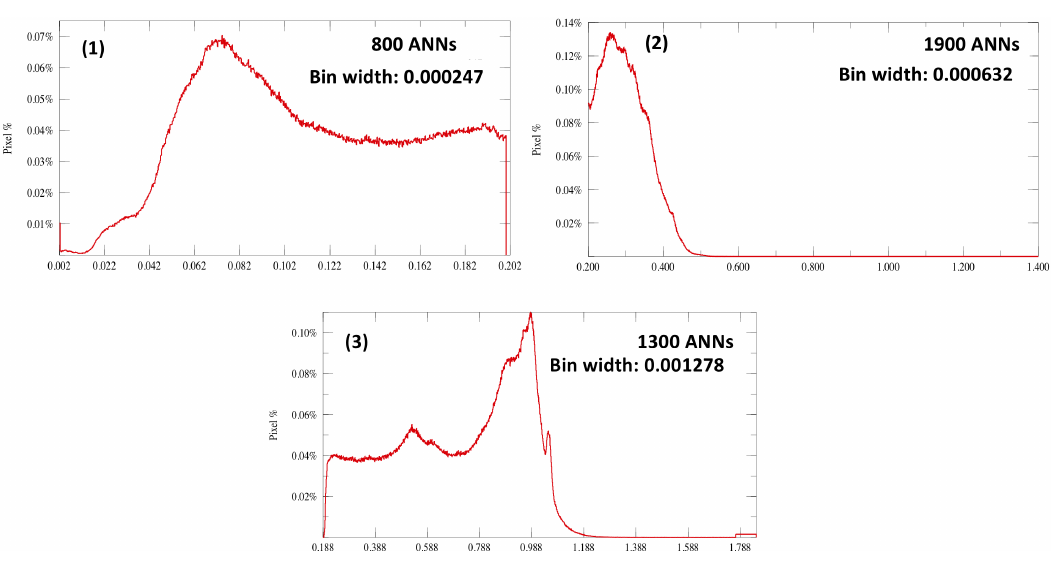
Figure 8. Histograms of the three groups of MODIS data to define the ANNs